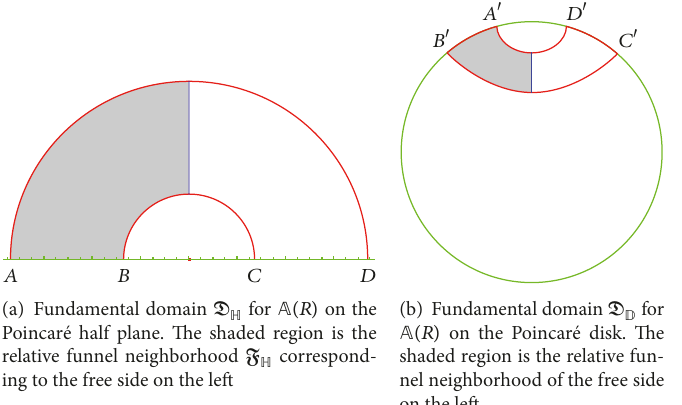
Figure 15: Fundamental domains for the uniformization of the hyperbolic annulus to the Poincar´e half plane and to the hyperbolic disk.